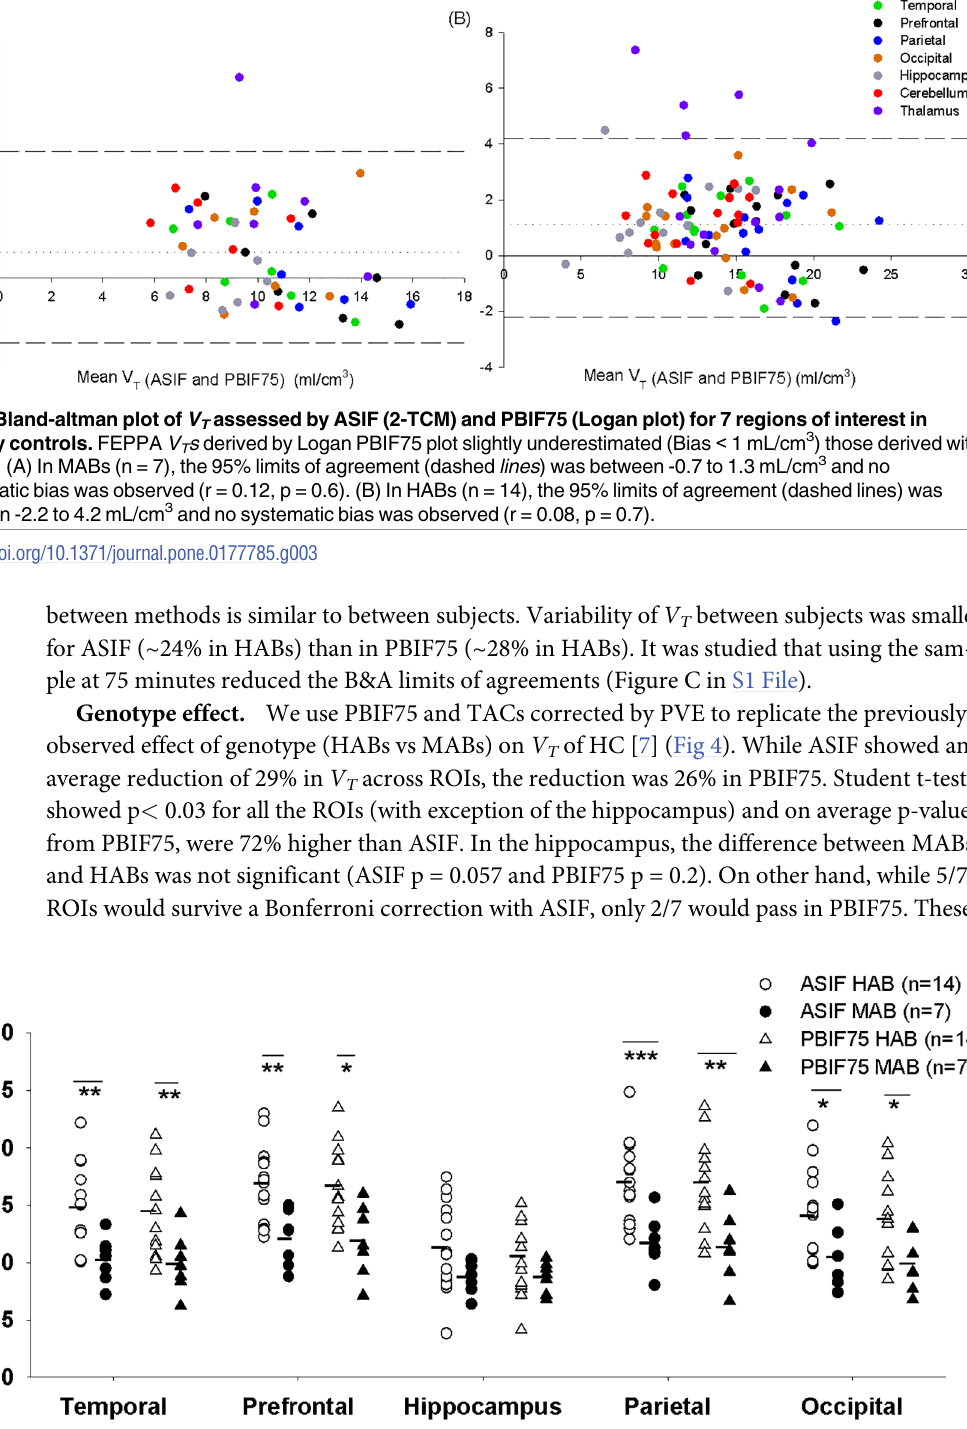
Fig 4. Total distribution volume ( V T ) calculated using ASIF (2-TCM) and PBIF75 (Logan plot). In Temporal, Prefrontal, Hippocampus, Parietal and Occipital regions stratified as HAB and MAB groups. ASIF showedan average reduction of 29% in V T across ROIs while PBIF showeda reduction of 26%. 5/7 ROIs survived the multiple region Bonferroni adjustmentusing ASIF and only 2/7 passed the Bonferroni adjustmentusing PBIF75. Images were partial volume effect corrected prior to TAC extraction. * p < 0.05, ** p < 0.01 *** p <